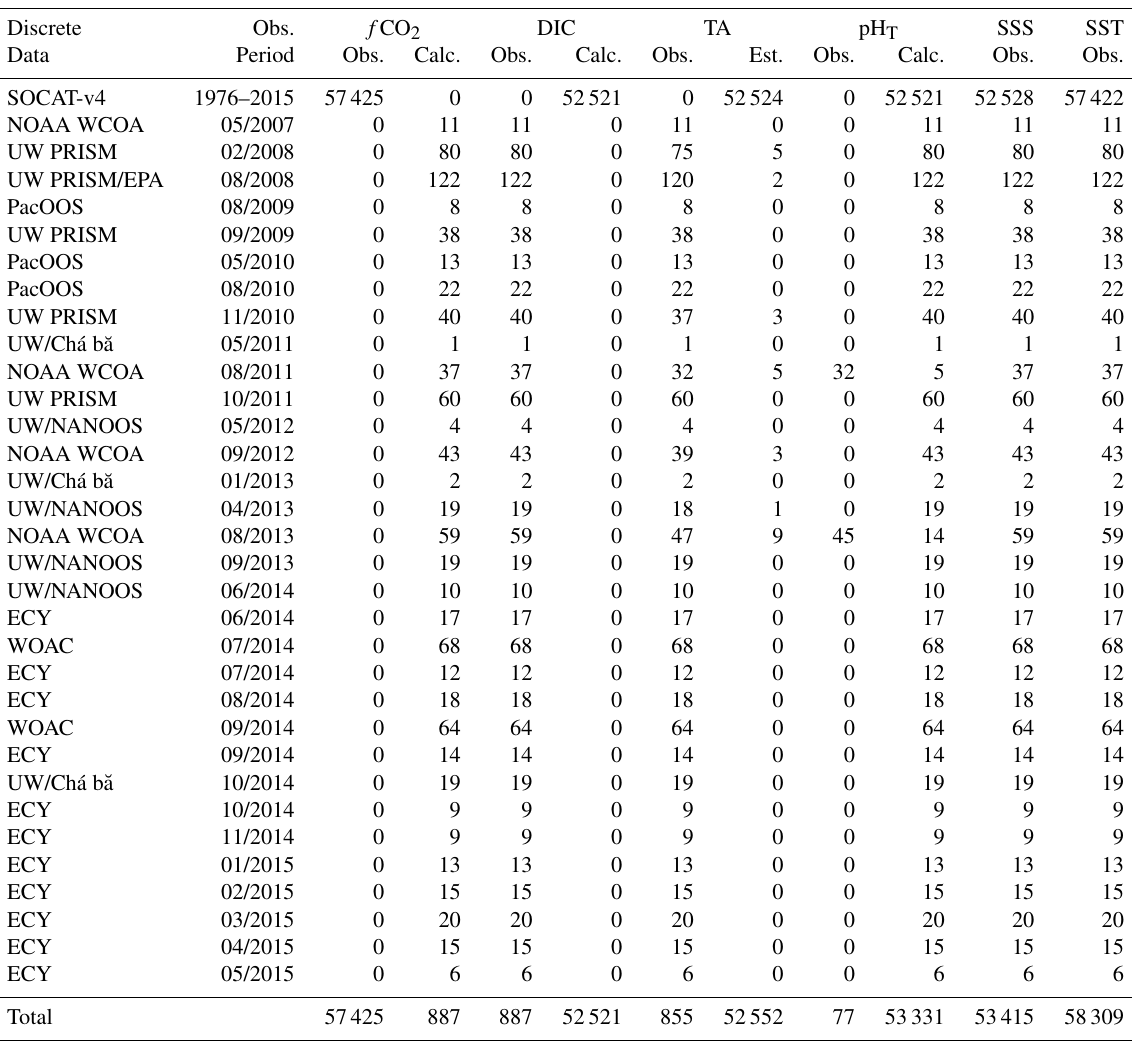
Table 2. SOCAT and discrete datasets incorporated into the analysis. The observing period and the number of f CO 2 , DIC, TA, pH, SSS, and SST values that were observed (Obs.), calculated (Calc.), and estimated (Est.) for each cruise are provided. Discrete Obs. f CO 2 DIC TA pH T SSS SST Data Period Obs. Calc. Obs. Calc. Obs. Est. Obs. Calc. Obs. Obs.